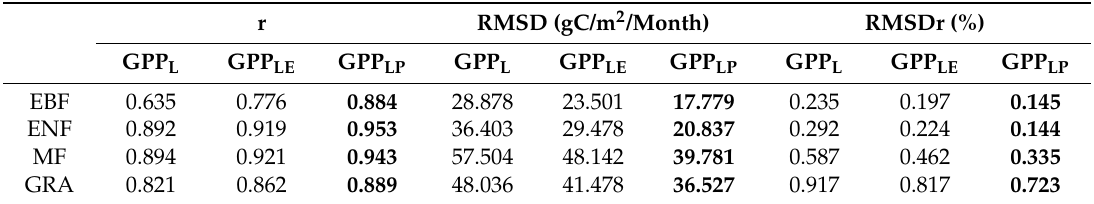
Table 3. Accuracy of model-estimated gross primary productivity (GPP) from three models by withholding plant functional type (PFT).